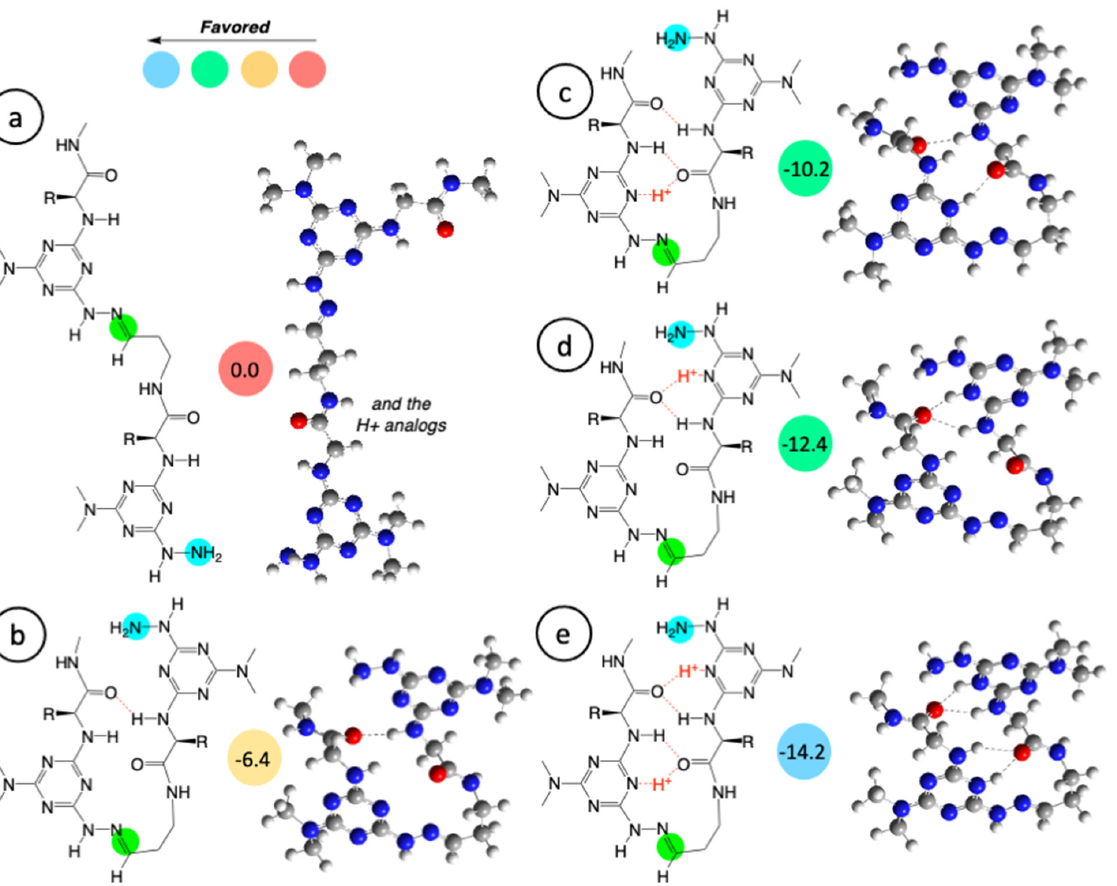
Figure 5. The relative energies in the templated intermediates relative to ( a ) the linear extended structure including ( b ) the neutral intermediate, ( c ) one monoprotonated intermediate, ( d ) the other monoprotonated intermediate, and ( e ) the proposed intermediate. Color reflects the relative energetic differences with values reported in kcal/mol.